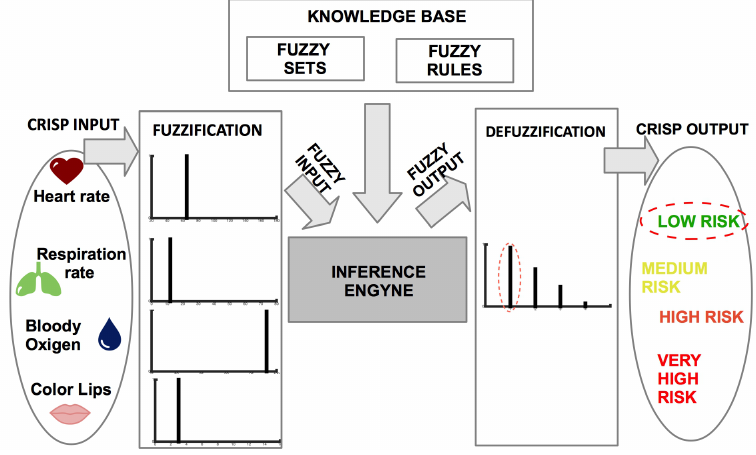
Figure 8. Inference process of the developed